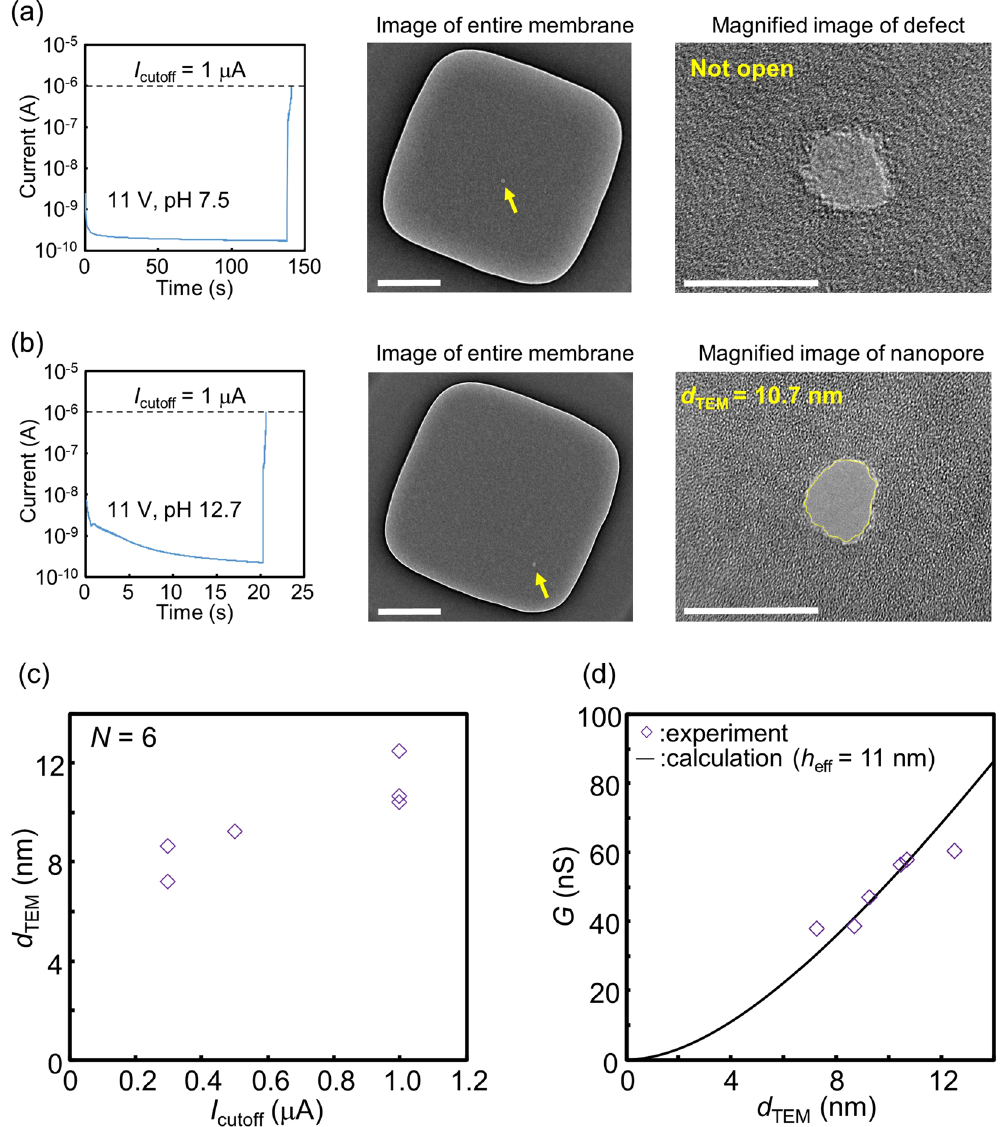
Figure 6. Nanopore fabrication in a 14-nm-thick SiN membrane by CBD under high-pH conditions. Current- time traces during CBD of SiN membranes, images of entire membranes after CBD and magnified views of created defects or nanopores when CBD was performed at ( a ) pH 7.5 and ( b ) pH 12.7. V cis and V trans were set at 11 V and 0 V, respectively, during CBD. I cutoff was set at 1 μ A. ( c ) Dependence of the equivalent diameter ( d TEM ) of the fabricated nanopores on I cutoff . ( d ) Relationship between conductance ( G ) of ionic current through the fabricated nanopores and d TEM . The solid line represents theoretically calculated